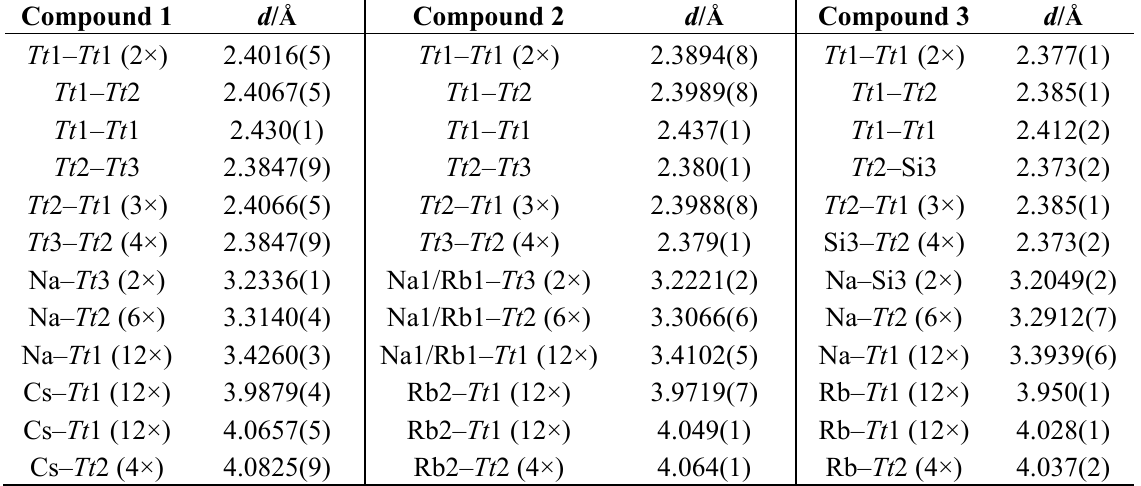
Table 4. Selected